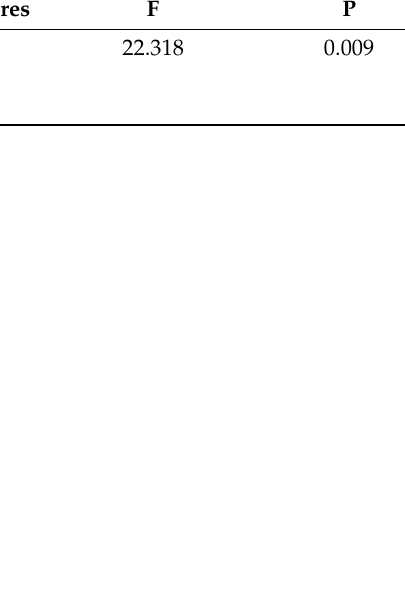
Figure 13. Displacement averages of M[s] and M[a] sequences.